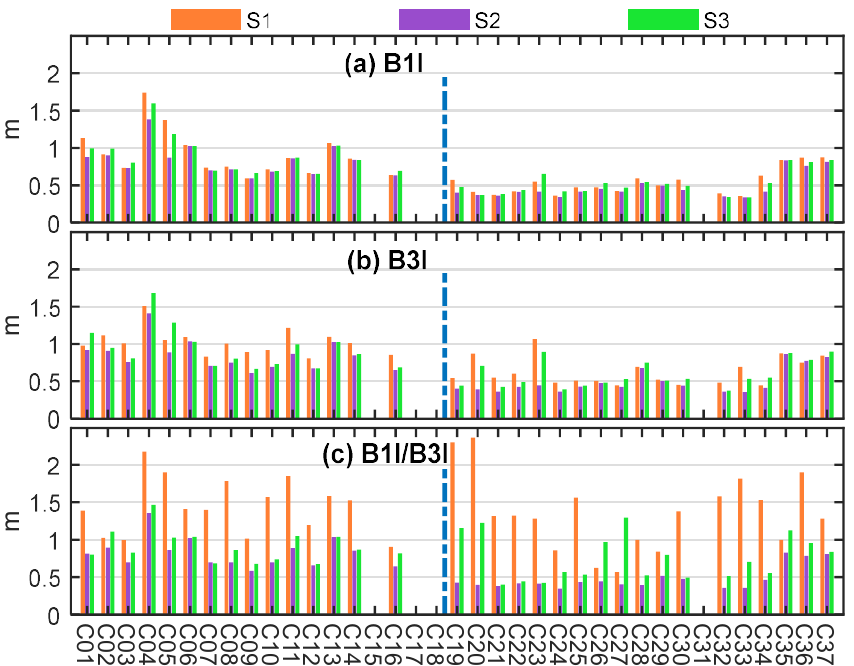
Figure 7. The BDS SISRE at B1I ( a ), B3I ( b ), and B1I/B3I ( c ) frequencies for different schemes. The BDS-2 and BDS-3 satellites are separated by the dashed line.